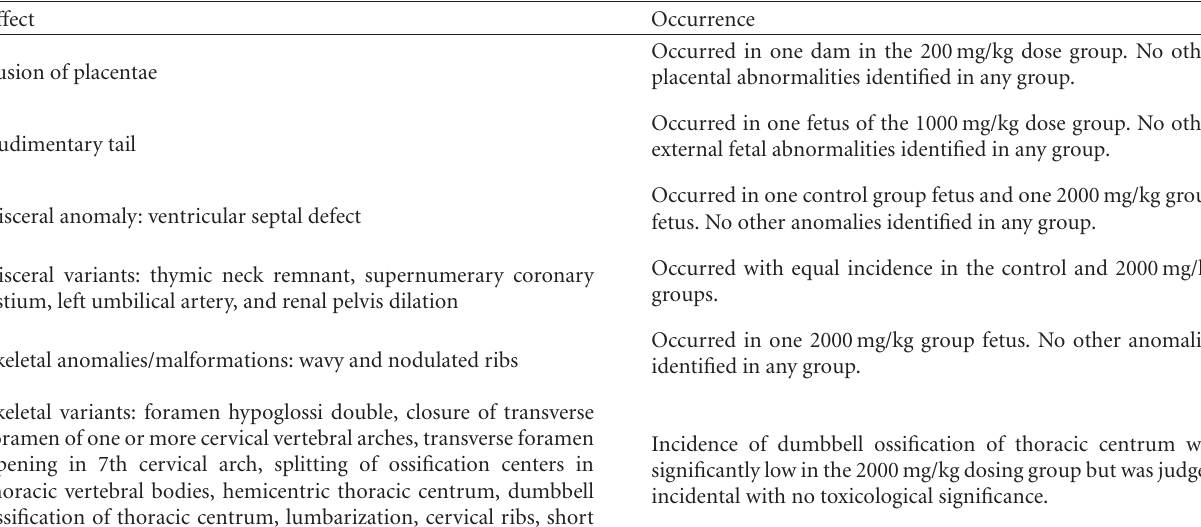
Table 2: Isolated embryo-fetal e ff ects noted during necropsy observations/examinations in the developmental toxicity study in